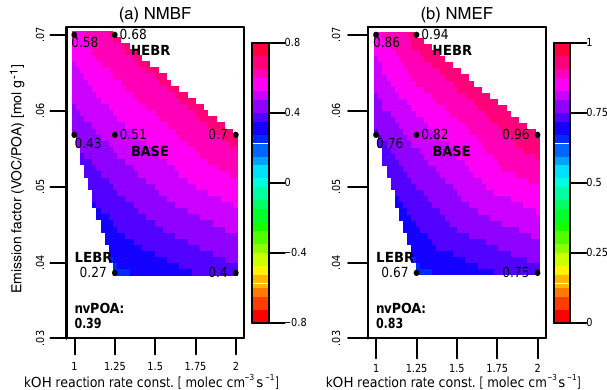
Figure 7. Evaluation of the effect of uncertain parameters for pc- SOA formation, emission factor, and OH reaction rate constant against OC measurements from IMPROVE and CSN networks. Data from January and July only of the CONUS11 simulations were used for this